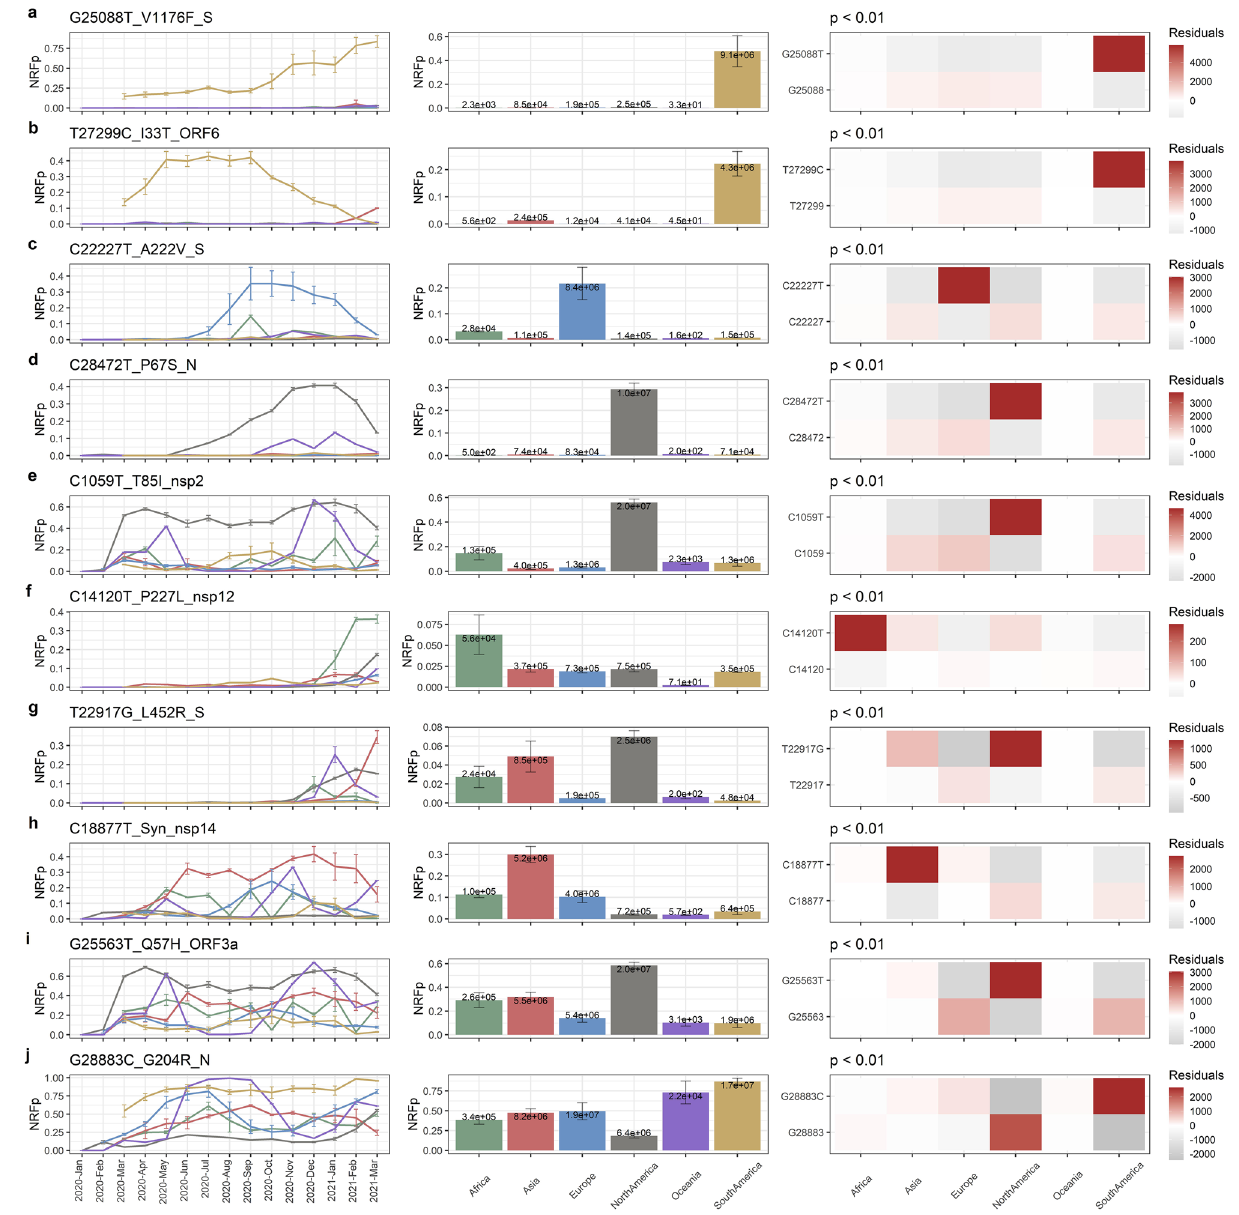
Figure 2. MF mutations are region-specific or have mid-frequencies in several regions. (Left-column) Normalized by cases Relative Frequency (NRFp) of the mutations by month separated by regions (green = Africa, red = Asia, blue = Europe, grey = North America, purple = Oceania, yellow = South America). (Middle-column) Total NRFp by region of the analyzed medium-frequency mutations. Numbers in each bar represents the estimated total number of cases of the particular mutation in that region. (Right-column) Chi-square p-value and Pearson residuals analysis of medium-frequency mutations. Upper line corresponds to the mutant state and the bottom line to the not-mutant state. Grey and red boxes mean negative or positive association with the state, respectively. Intensity of the colors means higher residuals that means greater contribution. (a–e) Region-specific medium-frequency mutations and (f–j) not-region-specific medium- frequency